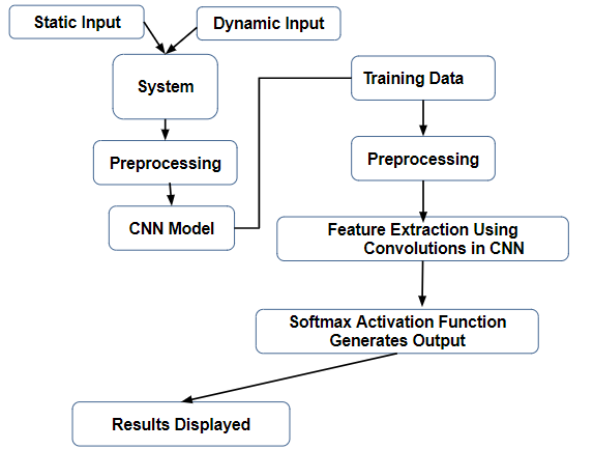
Fig. 1. Proposed Methodology Fig. 1 Represents Proposed Methodology diagram. In this proposed system, Data Pre-processing is performed for making input images suitable for analysis and operation. Data Pre-processing is different for static and dynamic input. CNN is used for feature extraction, SoftMax layer of CNN is used for classification